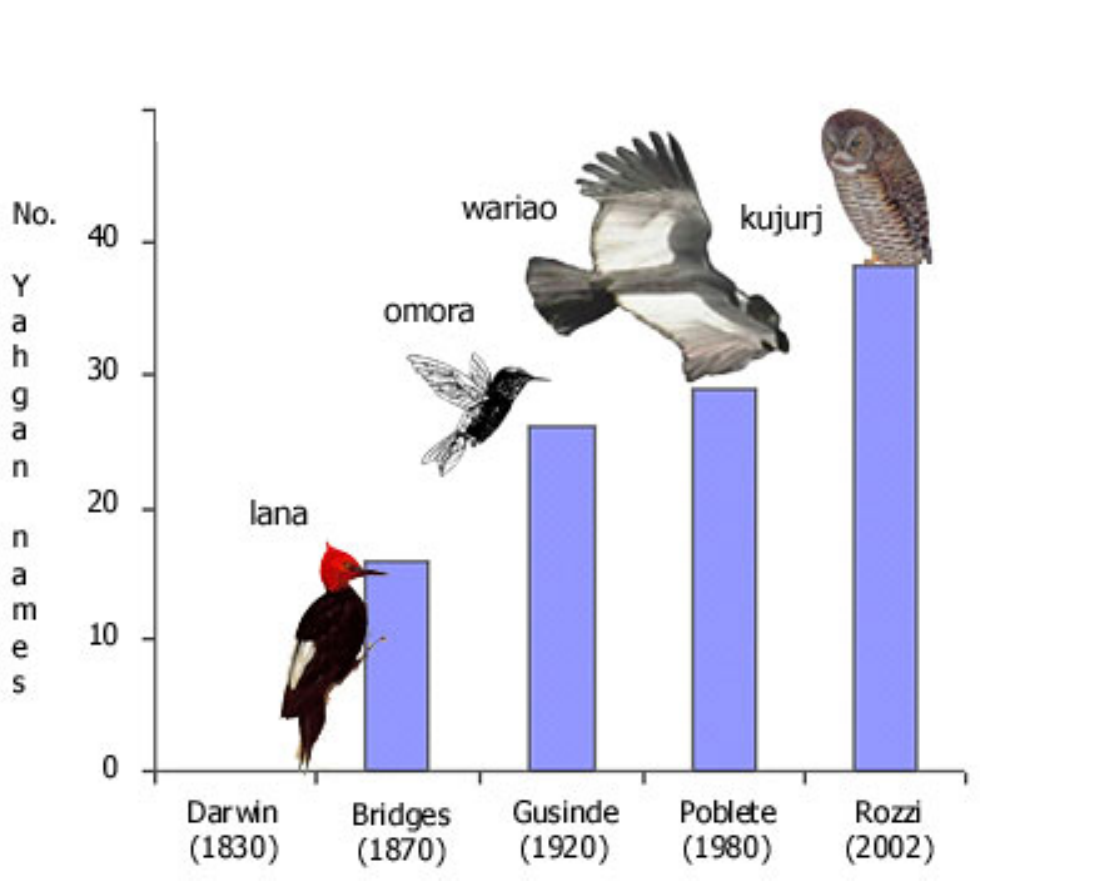
Fig. 8. The number of Yahgan bird names that are known to science continues increasing until today. For example, for forest bird species of the Cape Horn region, Charles Darwin (1839) did not register Yahgan names. Later, in the 1870s, the Anglican missionary Thomas Bridges included in the manuscript of his Yahgan-English dictionary, Yahgan names for 16 species, among them lana for the Magellanic woodpecker ( Campephilus magellanicus ). In the 1920s, the ethnographer Martin Gusinde continued discovering new Yahgan bird names, for example, Omora for the firecrown hummingbird ( Sephanoides sephaniodes ). More recently, in the 1980s the linguists Maria Teresa Poblete and Adalberto Salas (1997) added names for three other bird species, including the Andean condor ( Vultur gryphus ) or wariao in Yahgan. Finally, our own work has raised the number of known Yahgan names for forest bird species to 38, including names for nocturnal birds such as kujurj for the rufous-legged owl ( Strix rufipes ) (Rozzi 2002, Massardo and Rozzi 2004). Figure modified from Rozzi et al 2003 b